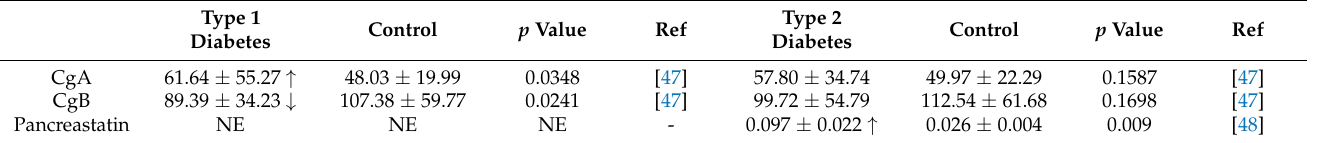
Table 1. Circulating concentrations (ng/mL) of CgA, CgB, and pancreastatin in diabetes. Type 1